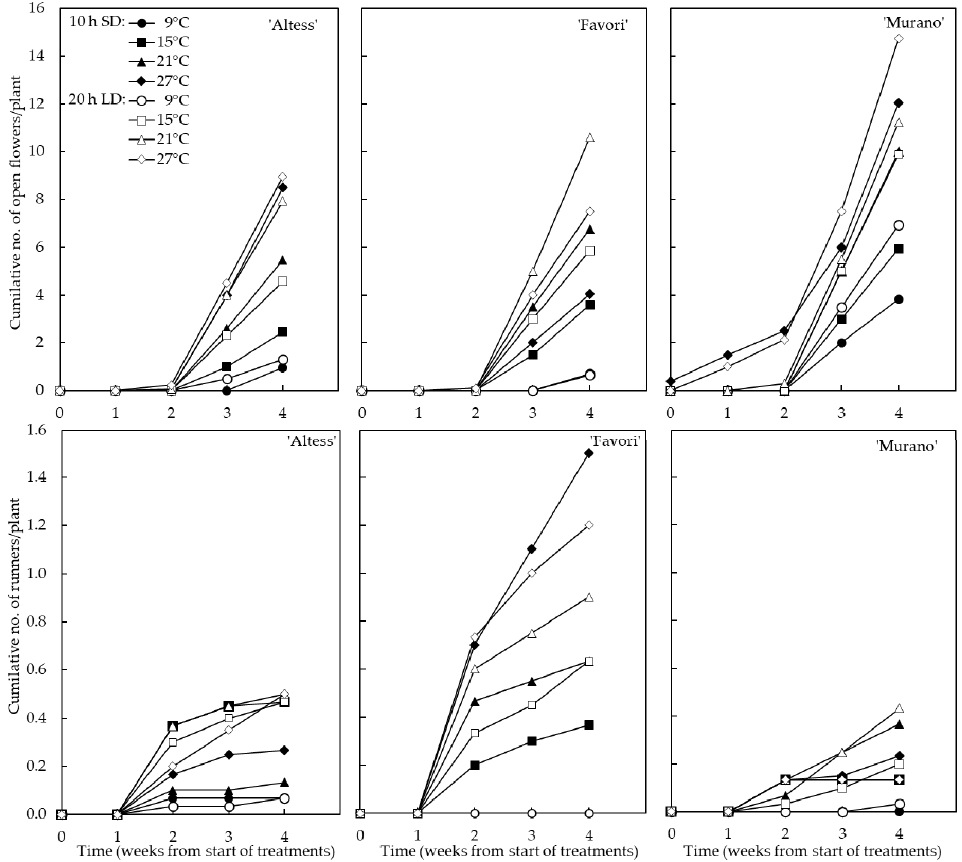
Figure 2. Time courses of cumulative flower and runner appearances during the 4-week precondi- tioning period in three EB strawberry cultivars. Data are the means of three replicates, each with 10 plants of each cultivar.